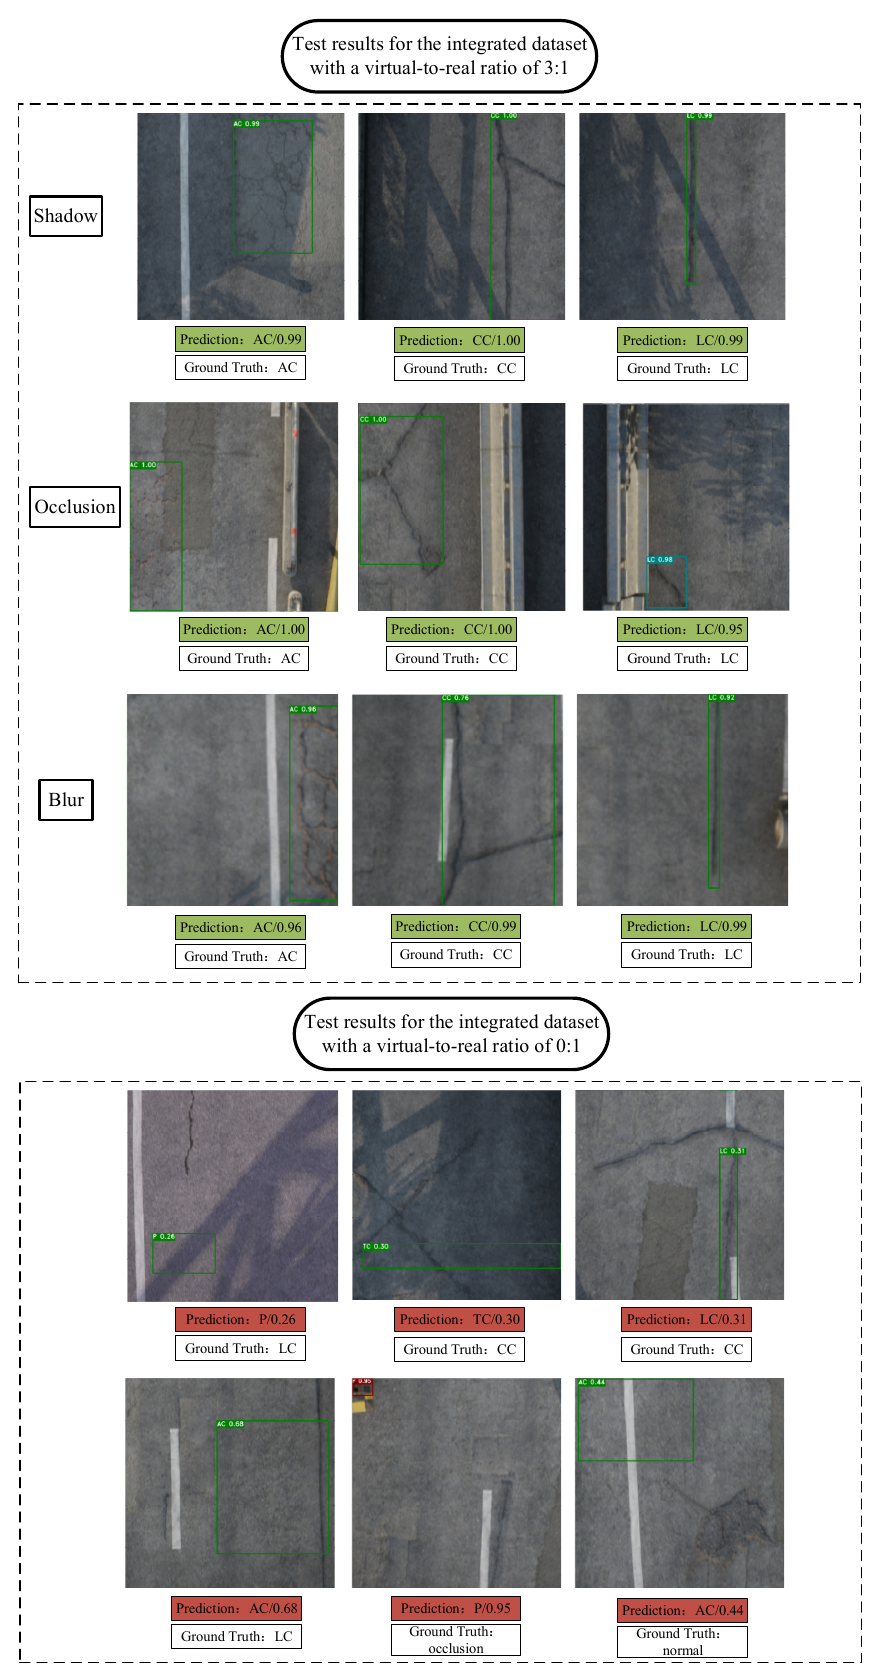
Figure 14. Test results of YOLOv5 network trained on two